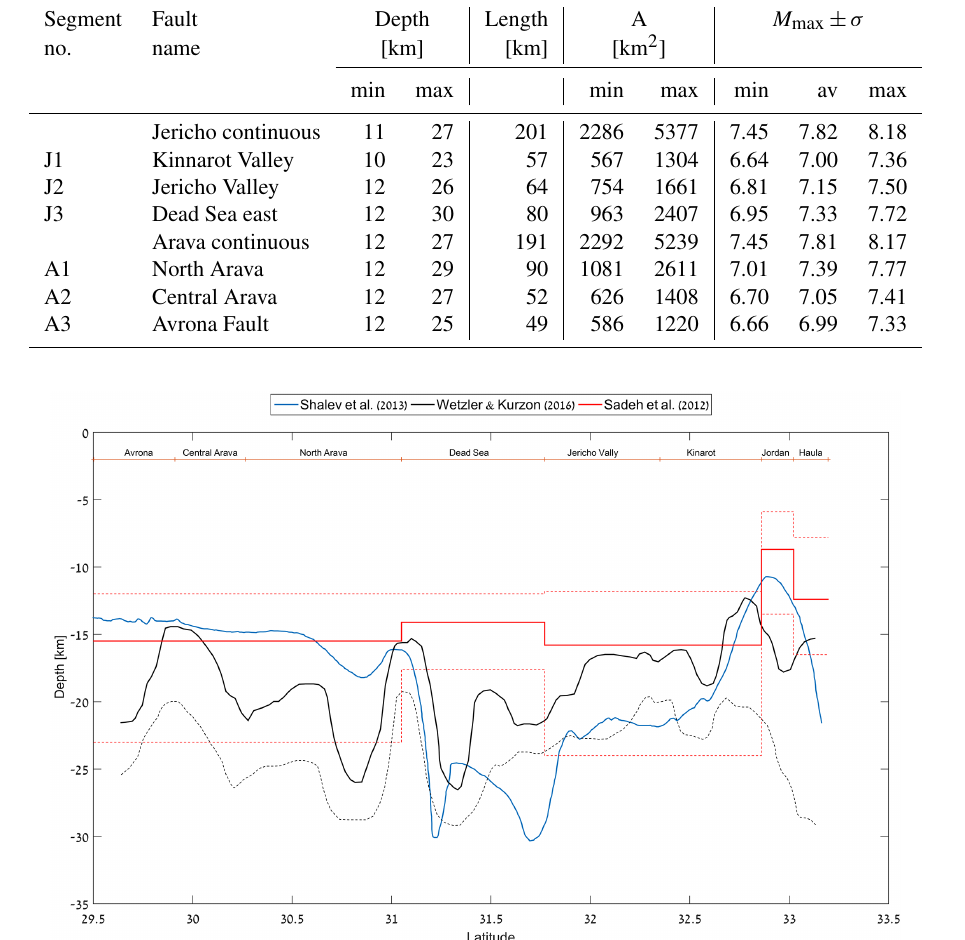
Table 2. Summary of the seismogenic depth estimates for the different DST segments (both for the segmented and continuous models) and their respective M max estimations, using the Hanks and Bakun (2002) empirical relationship.